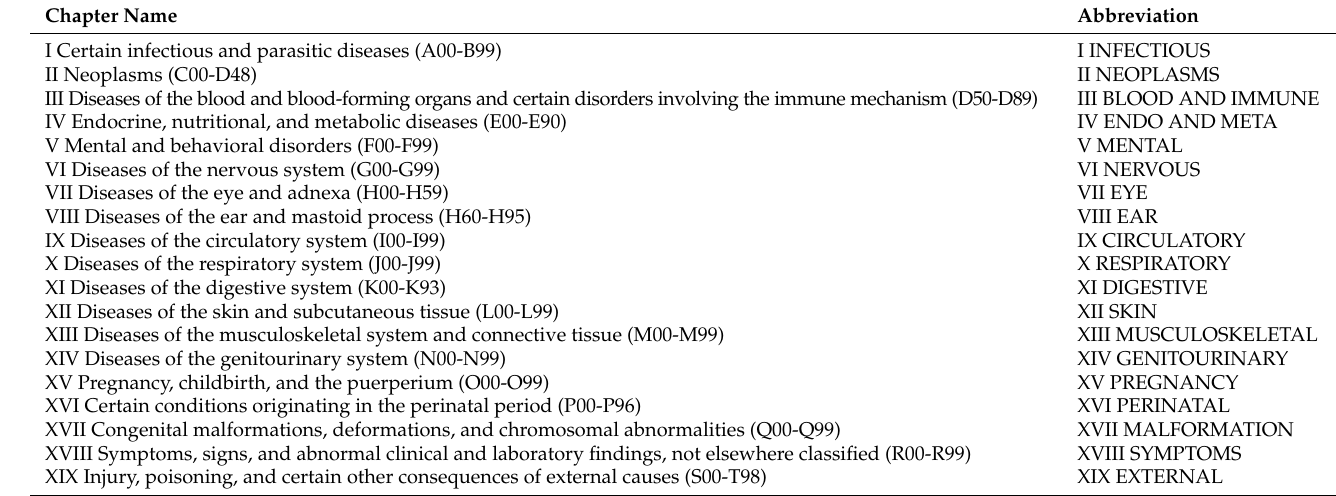
Table 1. Abbreviation of ICD-10 chapters.